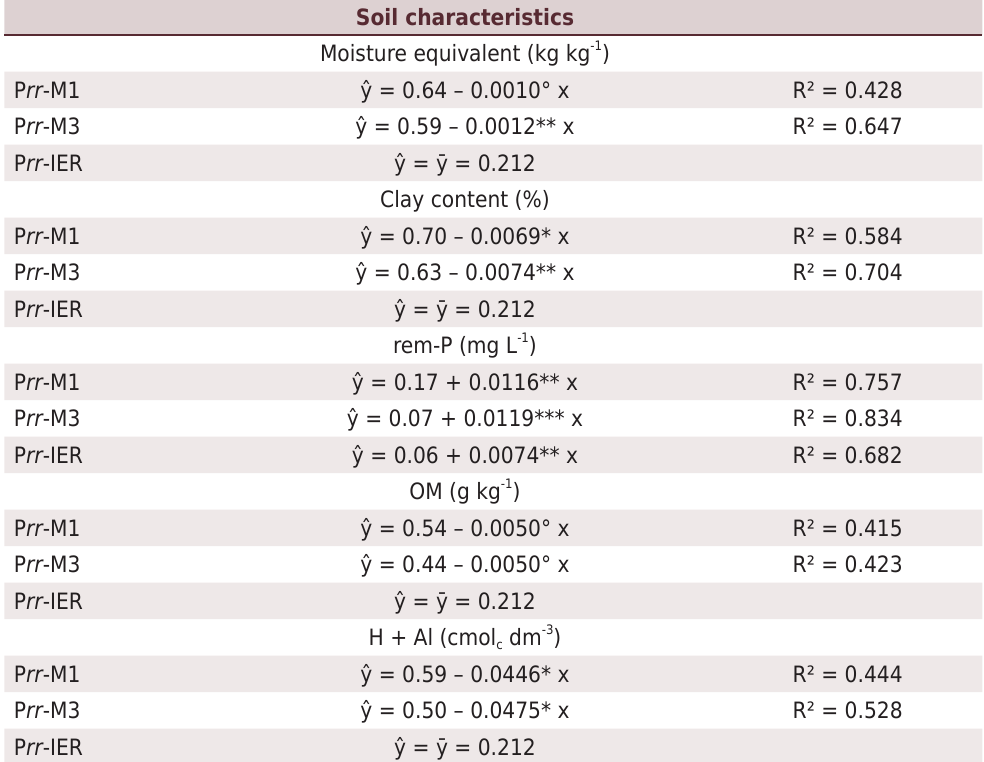
Table 4. Equations of P recovery rate by Melich-1 (P rr -M1), Mehlich-3 (P rr -M3), and Ion Exchange Resin (P rr -IER), according to soil characteristics related to soil P buffering capacity: moisture equivalent, clay content, remaining P (rem-P), soil organic matter (OM), and potential acidity (H + Al). R² = coefficient of determination